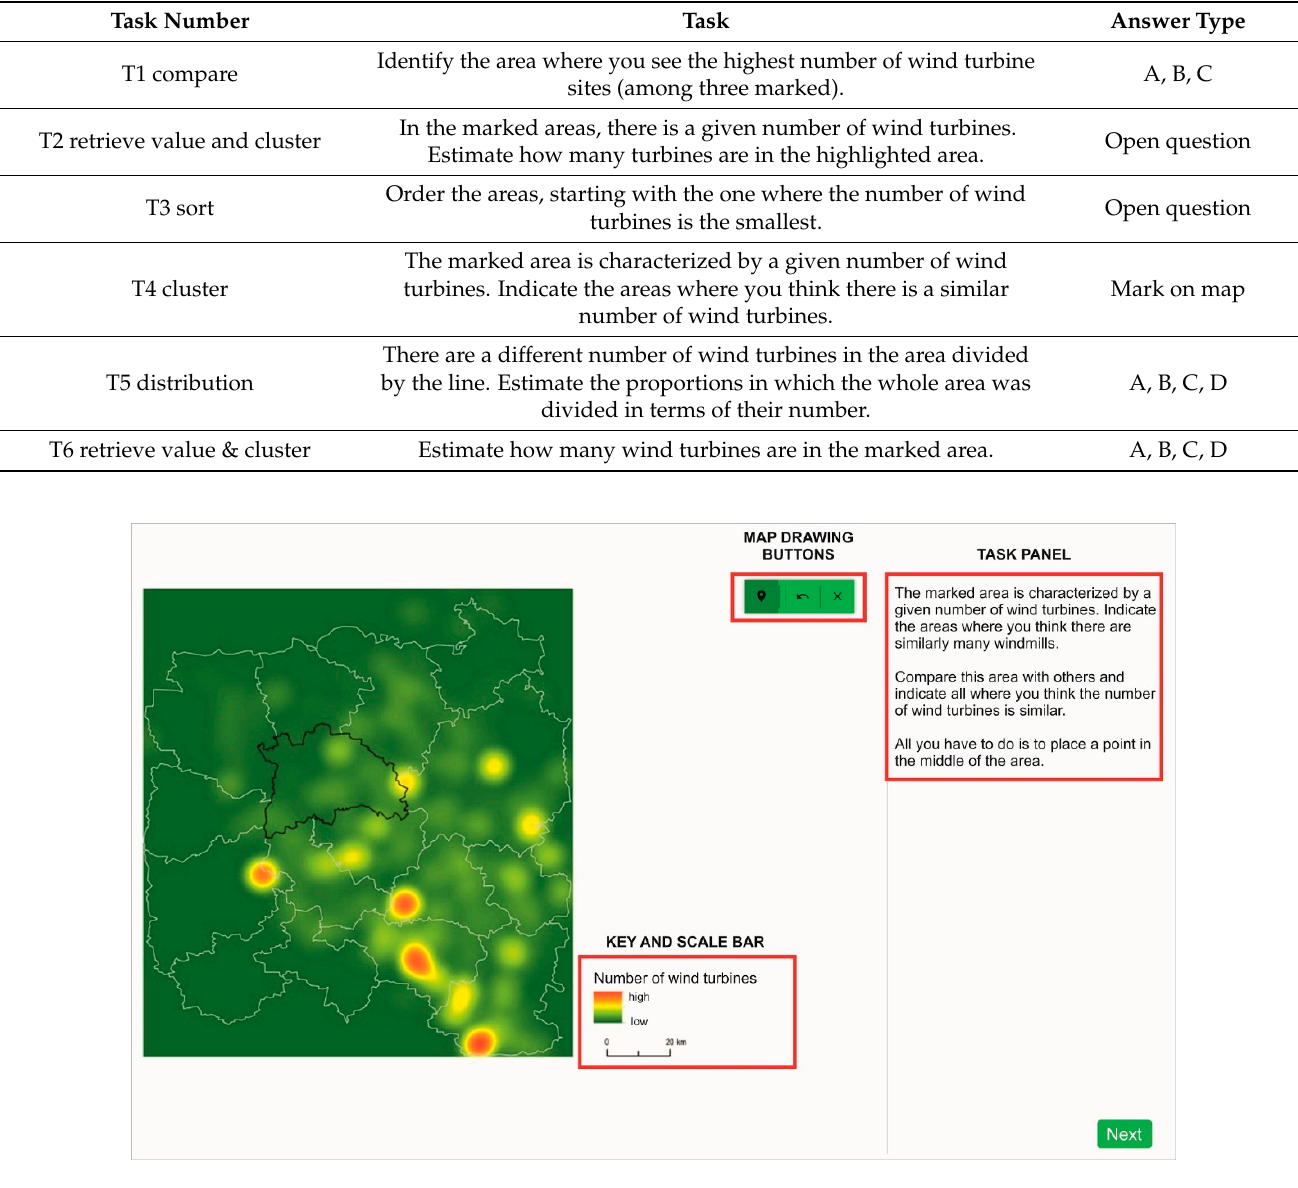
Figure 2. Example of the main window of the web application for participants: the map is on the left side of the window; the key, and scale bar are on the right side at the bottom; and the buttons with tools for drawing points are in the upper right corner. On the right is a task panel, in which the participants provide their answers.